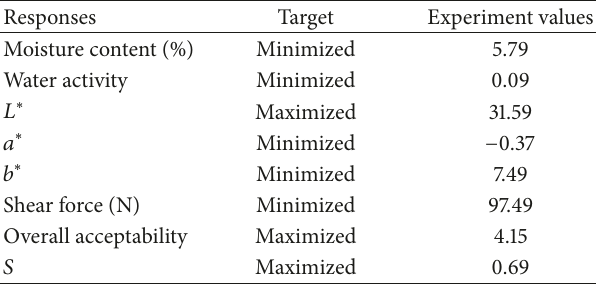
Table 7: Simultaneously optimized hot air drying conditions with target and experimental values of investigated